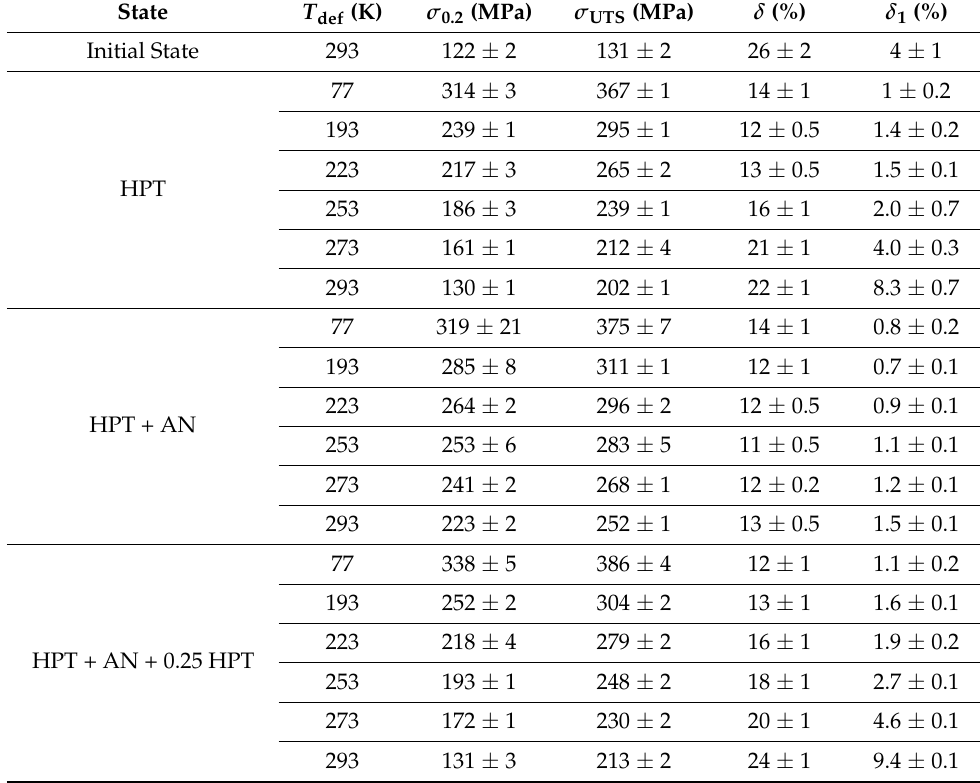
Figure 3. The stress–strain curves for the Al–0.4Zr alloy in the initial state, after HPT-processing (curve 1), after HPT-processing and subsequent annealing at 503 K for 1 h (curve 2), after HPT- processing, subsequent annealing, and additional HPT deformation to 0.25 (curve 3), 0.5 (curve 4), and 0.75 revolutions (curve 5). Table 2. Mechanical properties of Al–0.4Zr alloy in different structural states after tensile tests at different temperatures. σ 0.2 —yield stress, σ UTS —the ultimate tensile strength, δ —elongation to failure, and δ 1 —uniform elongation.